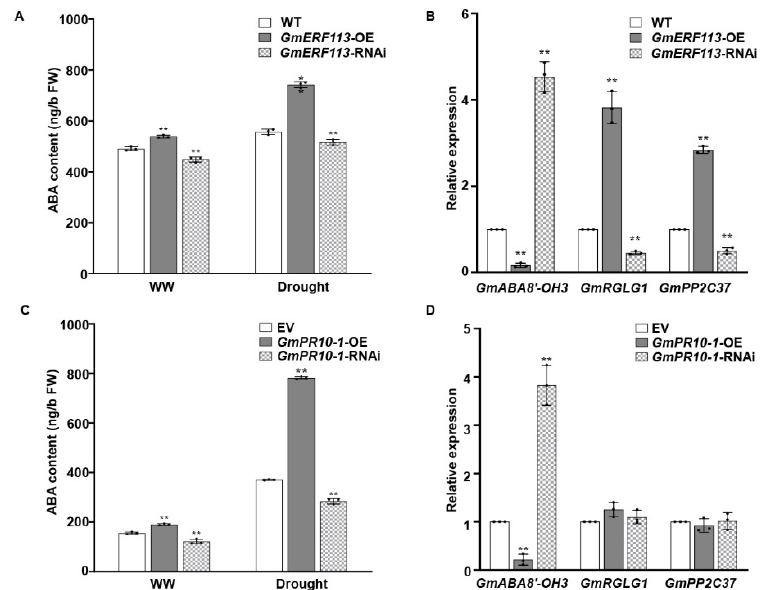
Figure 8. GmERF113 and GmPR10-1 function in ABA responses. ( A ) The ABA contents of GmERF113 transgenic soybean plants under normal conditions and drought treatment. ( B ) The relative expression of three ABA-related genes that were identified by RNA-seq analysis in GmERF113 transgenic soybean plants. ( C ) The ABA contents of GmPR10-1 transgenic soybean hairy roots under normal conditions and drought treatment. ( D ) The relative expression of three ABA-related genes that were identified by RNA-seq analysis in GmPR10-1 transgenic soybean hairy roots. The reference soybean gene GmActin4 and GmTubulin4 were used as an internal control to normalize the data. These experiments were performed on three biological replicates, each with three technical replicates, and were statistically analyzed using Student’s t -test (* P < 0.05, ** P < 0.01). The bars indicate the standard deviation of the mean.